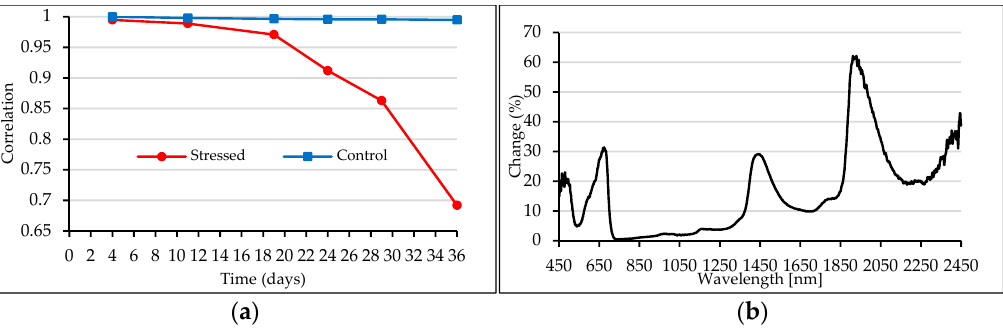
Figure 5. Spectral changes due to soil moisture deficit. ( a ) Pearson’s correlation of the mean spectra taken at the beginning of the experiment and those of the measurements during the experiment over time in both stress and control treatments; ( b ) Relative changes (%) between the first measured spectra at day 4 and the spectra measured at day 11.